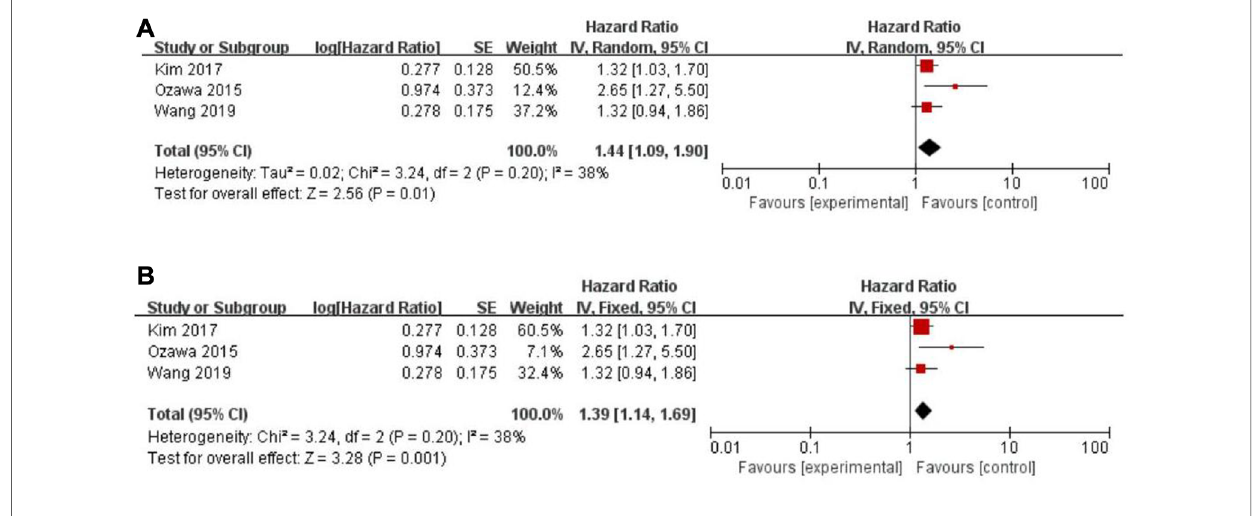
FIGURE 3 Forest graph on association of disease-free survival with different levels of platelet-to-lymphocyte ratio groups. ( A ) random effect model. ( B ) fi xed effect model.